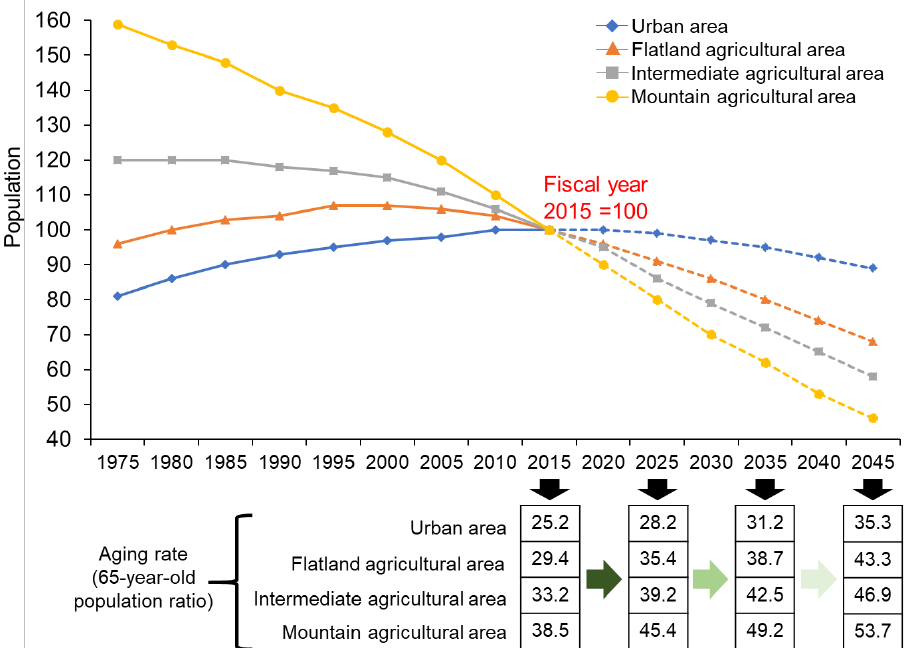
Figure 1. Population trends and future forecasts by agricultural area type (modified from [15], MAFF 2019, [Ministry of Agriculture, Forestry and Fisheries]).